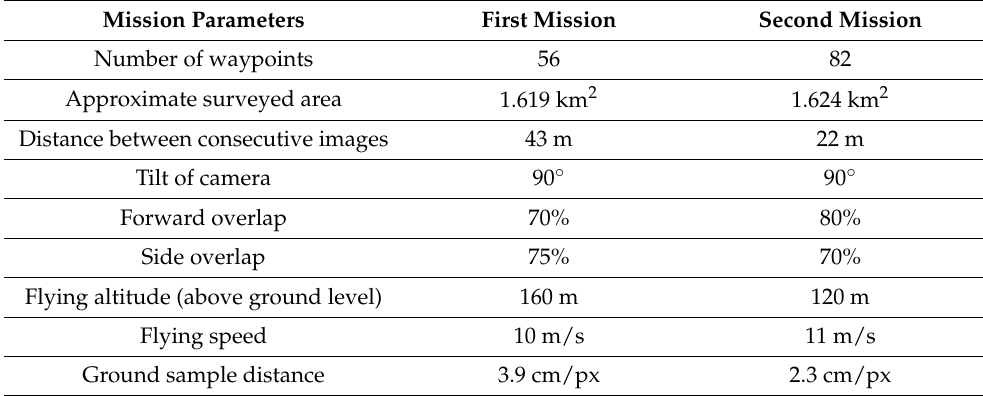
Table 3. The parameters of planned UAS missions in senseFly eMotion 3 software.